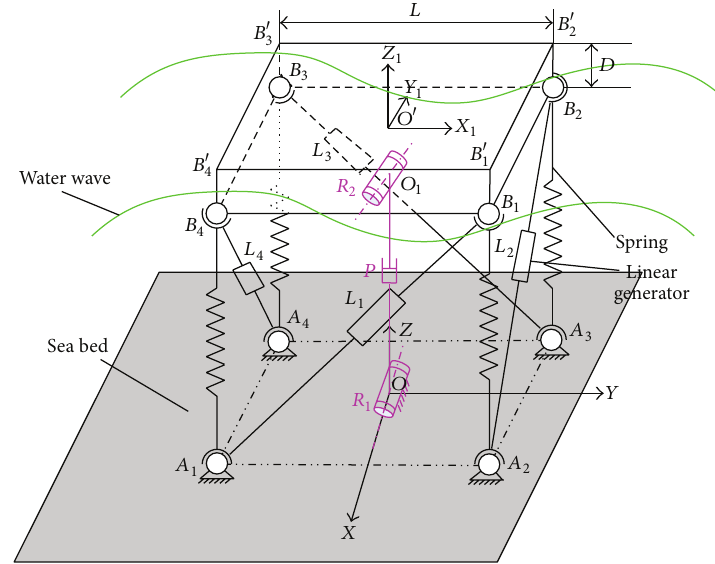
Figure 1: A tensegrity-based water wave energy